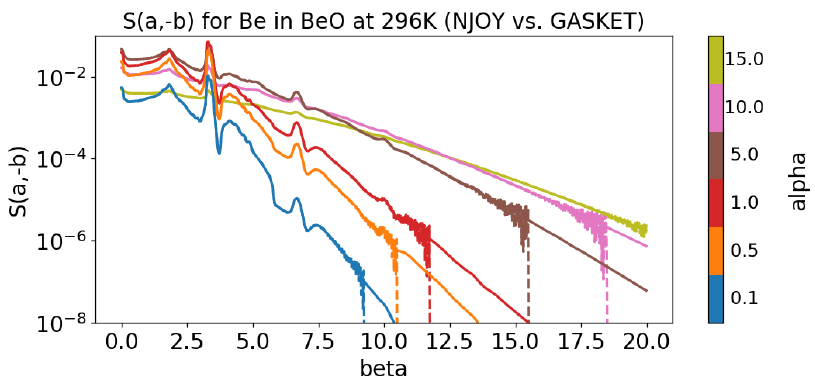
Figure 3: The scattering law for Be in BeO was produced using both the LEAPR (solid line) method as well as the GASKET (dashed line)